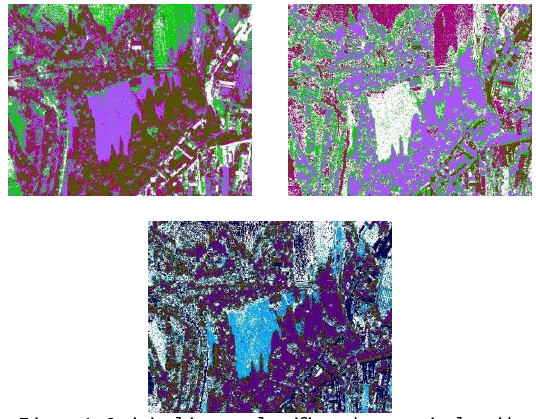
Figure 3: Shadows mask calculated with the WBI index